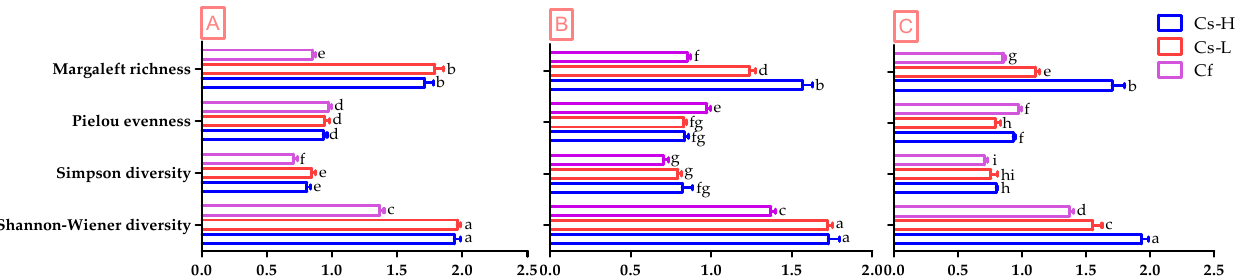
Figure 2. Shrub diversity in Cupressus funebris stands under pure forest reconstruction patterns at different densities. Shrub diversities (mean ± SD, n = 3) in Cupressus funebris after reconstructions of Alnus cremastogyne ( A ), Toona sinensis ( B ), and Cinnamomum septentrionale ( C ) at high or low intensity were investigated. Different letters indicate significant differences for the same diversity index among different intensities within the same reconstruction patterns compared by Fisher’s least significant differences (LSD) test at p < 0.05.